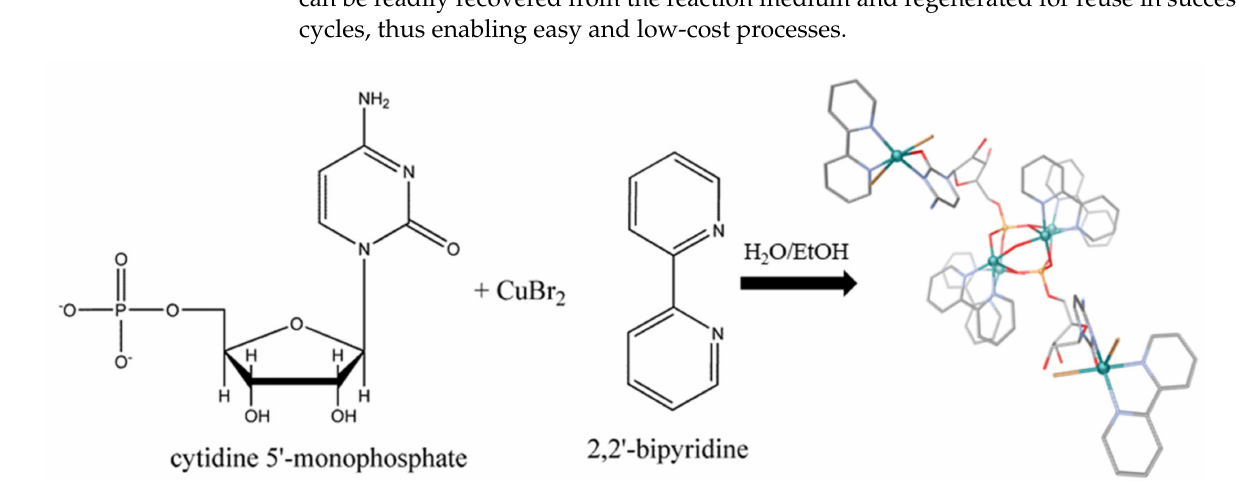
Scheme 1. Schematic representation of the reaction pathway: cytidine monophosphate di-anion as a chiral inductor reacts with copper bromide and the 2,2’-bipyridine as a modulator to build [Cu 6 (bipy) 6 (CMP) 2 ( µ -O)Br 4 ] 2+ moieties. Color scheme: cyan, copper; orange, phosphorous; red, oxygen; blue, nitrogen; grey, carbon; brown, bromide. Hydrogen atoms are omitted for the sake of